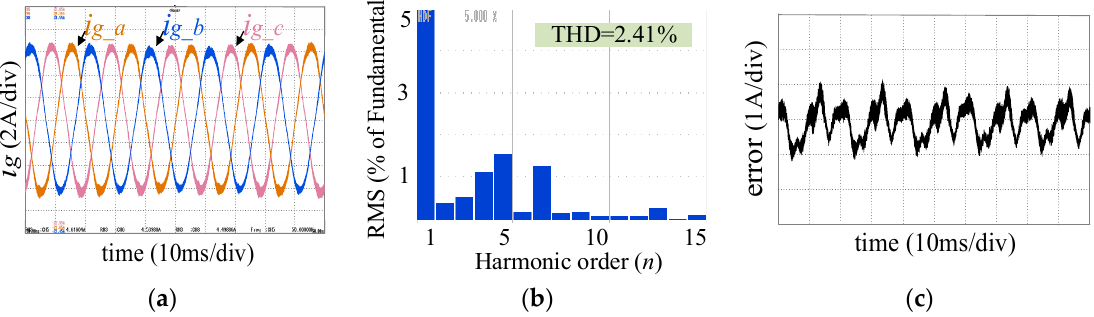
Figure 24. Experimental results of Farrow-FOPRRC with variable grid frequency. ( a ) Grid current i g . ( b ) Harmonic spectrum of i g_c . ( c ) Current tracking error ε .